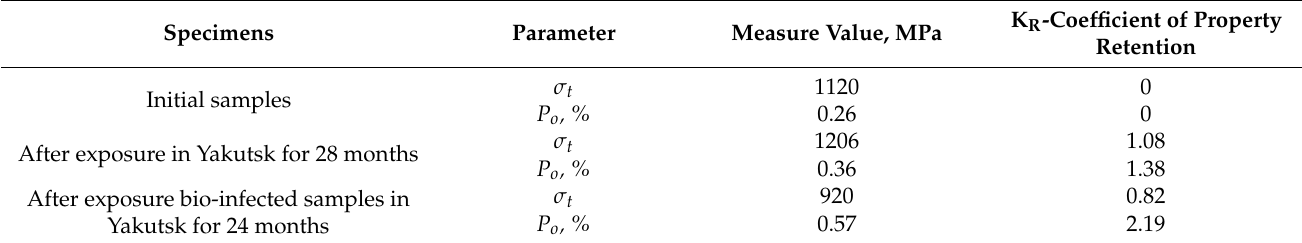
Table 10. Results of comparative tests of BFRP No. 1 for axial tension and open